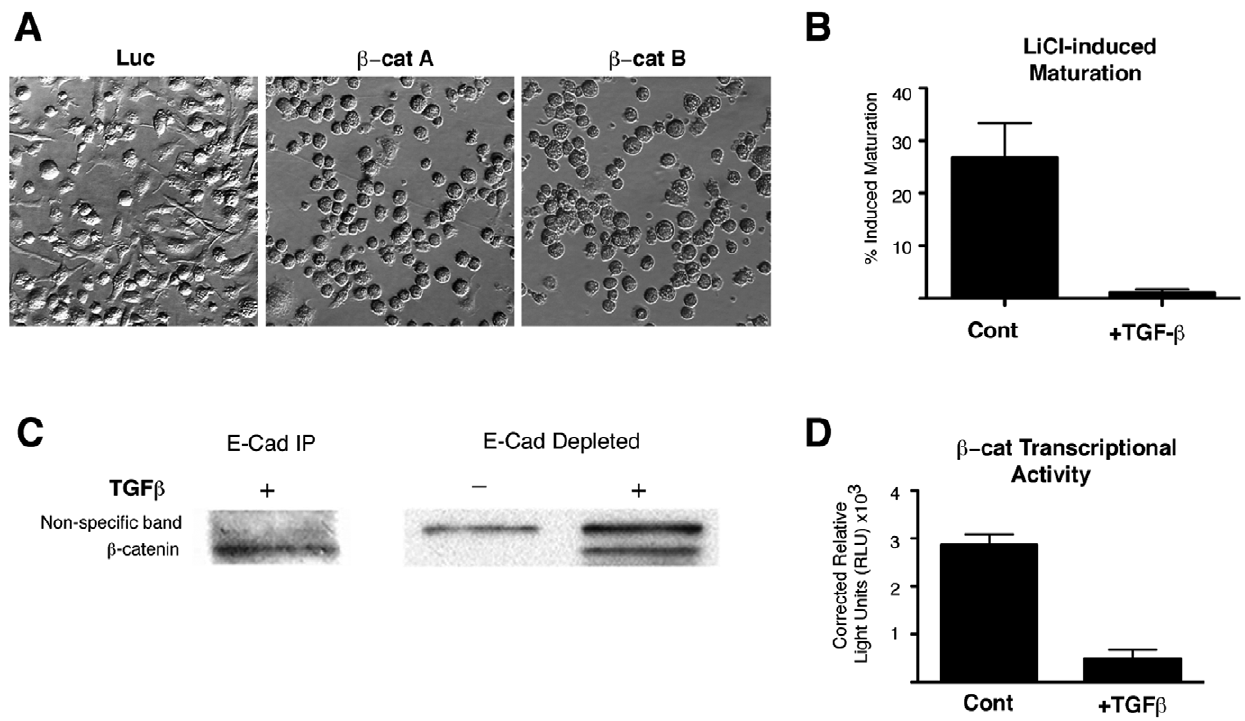
Figure 6. TGF- b Disrupts b -catenin Function. (A) BMDCs were infected with either control or b -catenin shRNA as in Fig 2. shRNA infected cells were analyzed by microscopy 6 days after infection. Images are representative of 3 experiments. (B) BMDCs were cultured for 5 days with or without TGF- b , then stimulated with 10 mM LiCl. 24 hours after stimulation, maturation was assessed by flow cytometry as in Fig 1. Graphs display data from 3 experiments as mean 6 SEM. (C) BMDCs were cultured for 5 days in the presence ( + TGF- b ) or absence (Cont) of TGF- b . CD11c + cells were purified on ice with magnetic beads and lysed immediately to avoid mechanical maturation induced changes. E-Cadherin (E-Cad) was immunoprecipitated from lysates and both precipitate and E-Cad depleted fractions were analyzed for b -catenin by western blot. Blots are representative of 2 experiments. (D) Day 2 BMDCs cultured with ( + TGF- b ) or without (Cont) TGF- b were infected with TCF/LEF lentiviral luciferase reporters. On Day 5, cell lysates were prepared from infected cells, luciferase substrate was added to lysates, and the resulting luminescence was measured. Graph shows data from 3 experiments as mean + / 2 SEM.